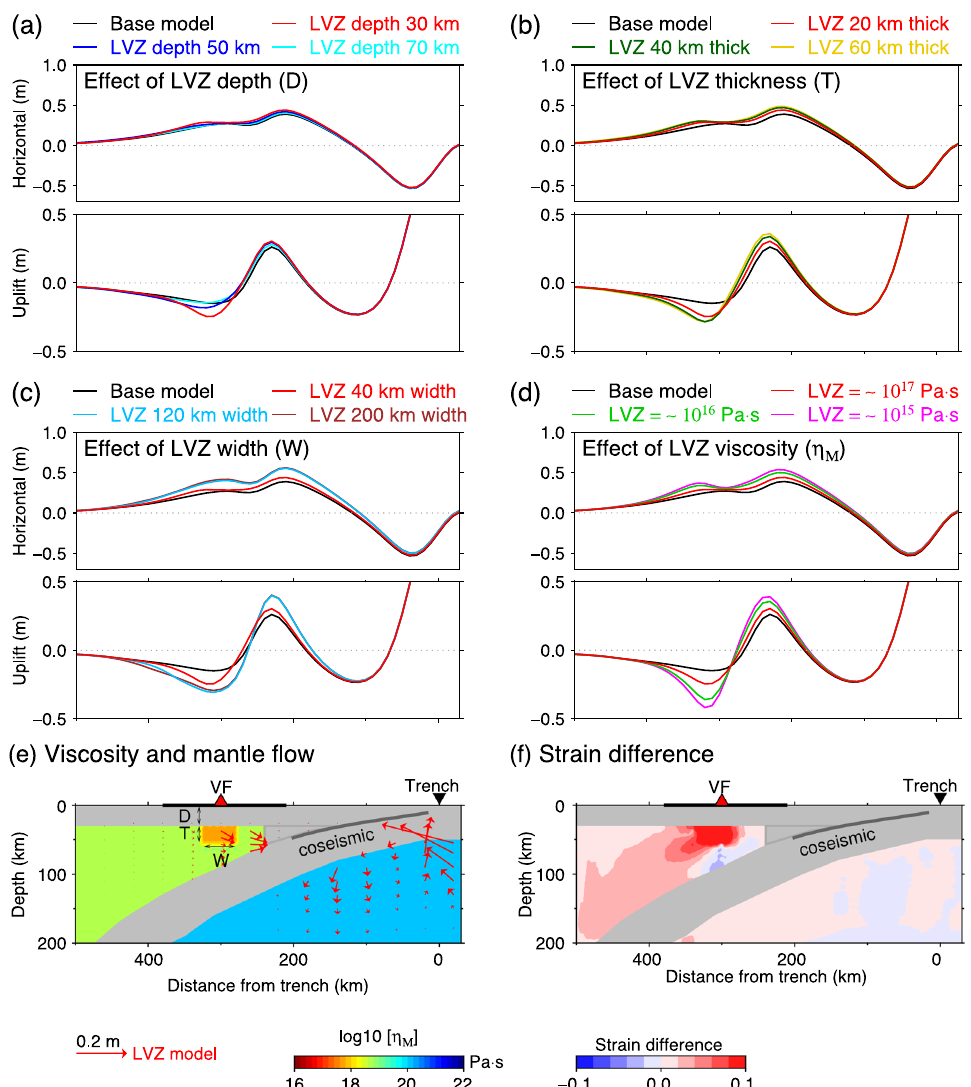
Fig. 8 The effect of LVZ on the 3-year postseismic deformation a the surface displacement by the models with top depth D at 30 km, 50 km, and 5.6 10 17 Pa s. b The surface displacement by the models with thickness T at 20 km, 40 km, and 60 km, 70 km, while T 20 km, W 40 km, and η M = = = × · while D 30 km, W 40 km, and η M 5.6 10 17 Pa s. c The surface displacement by the models with width W at 40 km, 120 km, and 200 km, while = = = × · D 30 km, T 20 km, and η M 5.6 10 17 Pa s. d The surface displacement by the models with Maxwell viscosity η M at 5.6 = = = × · 5.6 10 15 Pa s, while D 30 km, T 20 km, and W 40 km. e The trench-normal profile depicts the viscosity distribution and mantle flow pattern for × · = = = the model with D 30 km, T 20 km, W 40 km, and η M 5.6 10 17 Pa s. f The distribution of strain difference corresponds to the model shown in = = = = × · ( e ). Strain difference strain in LVZ model – strain in base model. All viscous strain (second invariant of the deviatoric strain tensor) is normalized by = the coseismic